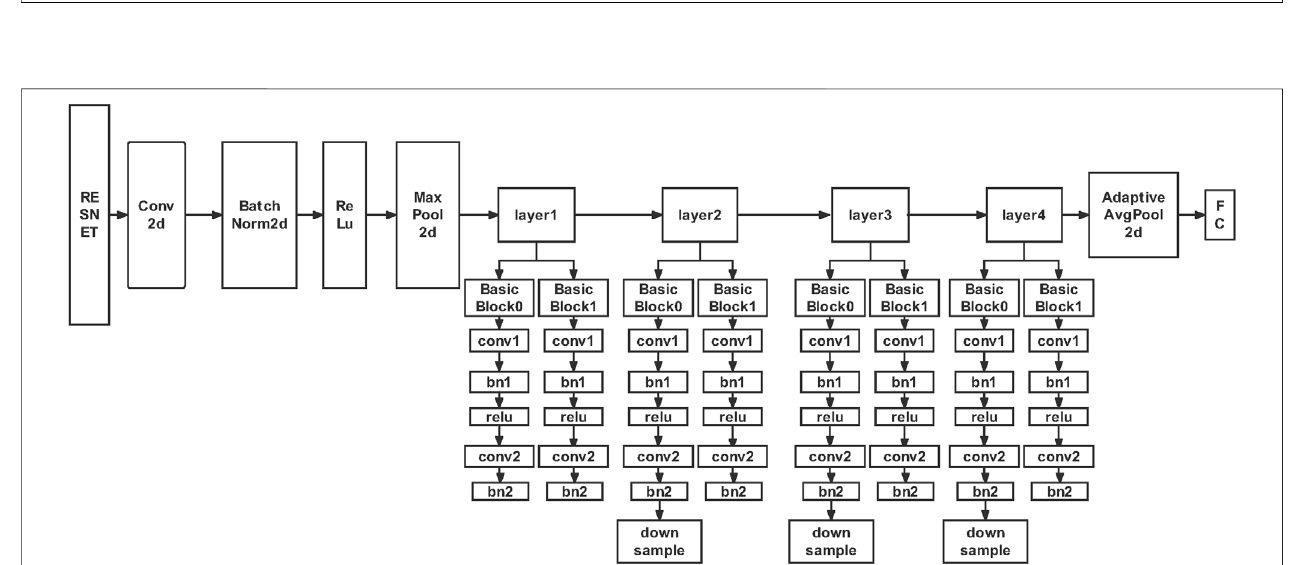
FIGURE4| Resnetmodelframeworkstructure.ThecharacteristicofResnetisthatitiseasytooptimizeandcanimproveaccuracybyincreasingdepth.Theinternal residual block uses jump connection to alleviate the problem of gradient disappearance.